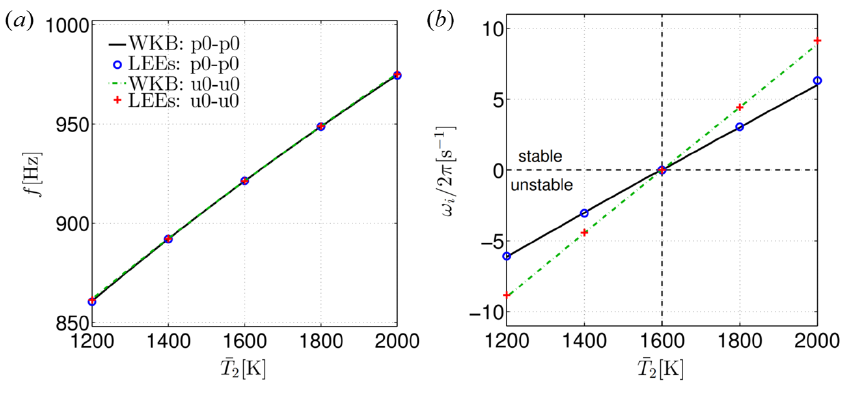
Figure 4. Variation of the first transverse (1T) mode as a function of the outlet mean temperature for the open–open ends (p0-p0) and the closed–closed ends (u0-u0): ( a ) resonant frequencies and